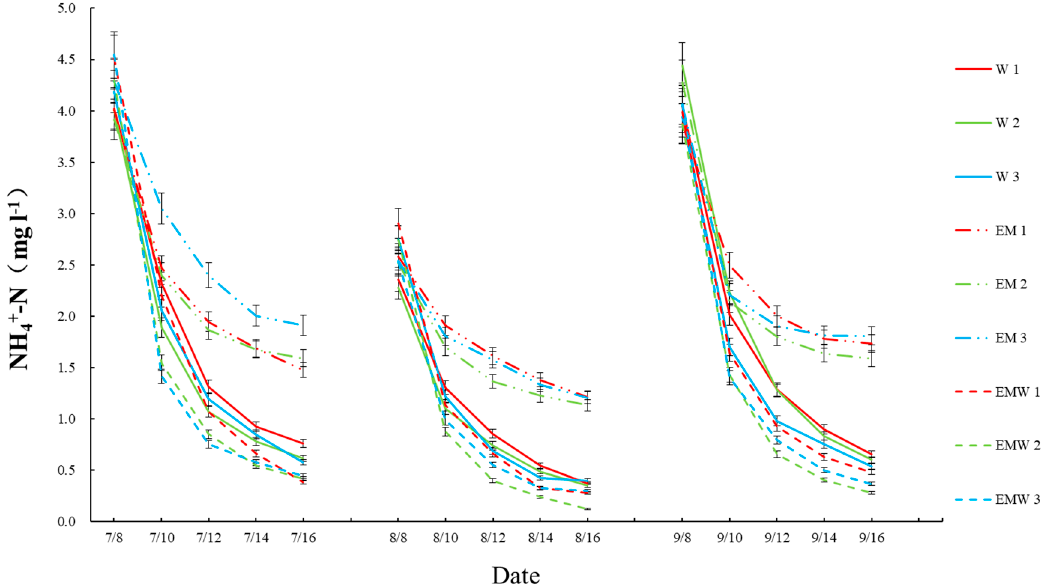
Figure 3. NH 4 + -N concentration changes with time in wetlands.